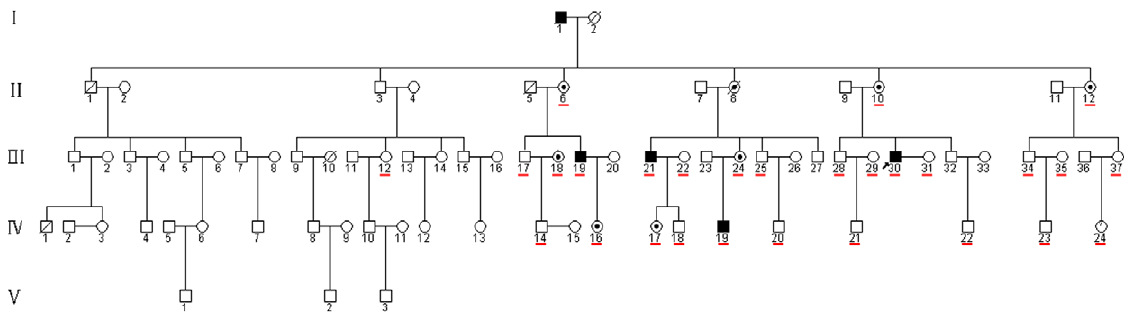
Figure 1. The pedigree of X-linked OA1. A filled square indicates an affected male and a dot in the middle of the circle indicates a carrier. The proband is marked by an arrow. The underline indicates family members enrolled in this study.